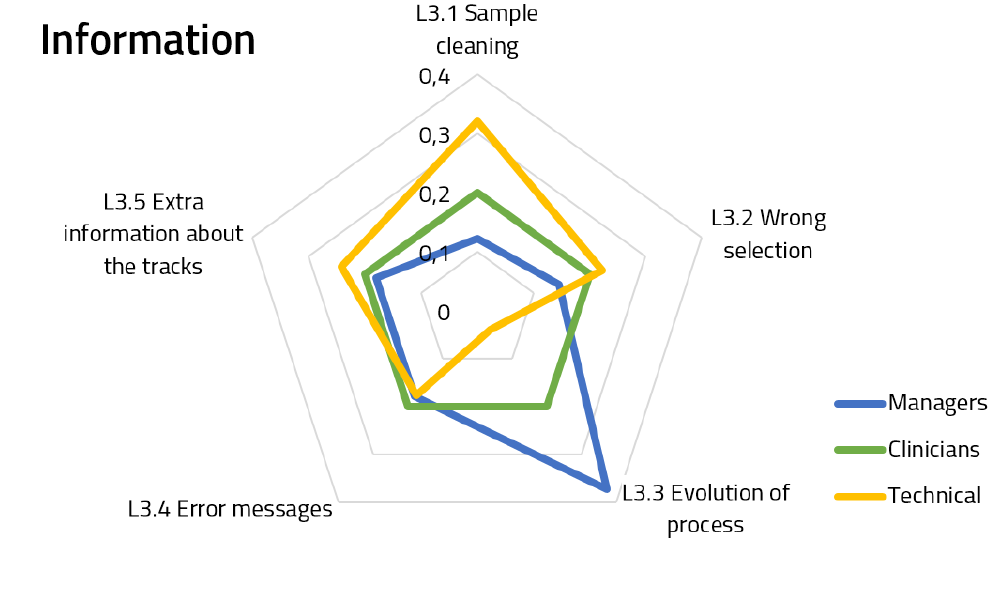
Figure 7. Priorities for information functional module features.